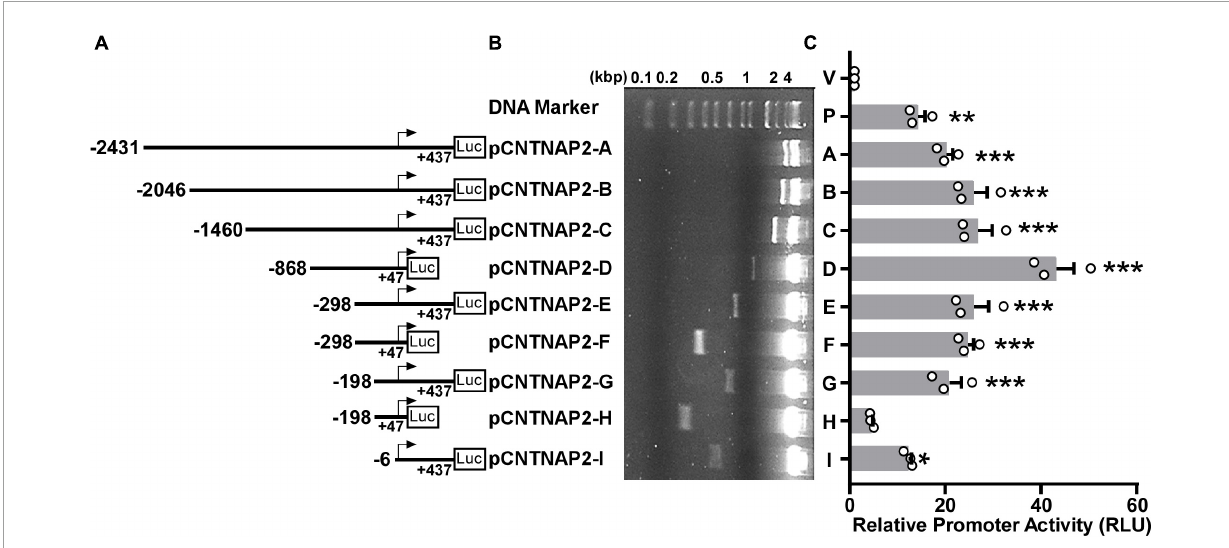
FIGURE4 Deletion analysis of the human CNTNAP2 gene promoter. (A) Schematic diagram of the human CNTNAP2 promoter deletion constructs. Various lengths of the human CNTNAP2 gene 5 (cid:48) flanking region were cloned into the pGL3-Basic promoter upstream of the Firefly luciferase gene (Luc). The numbers represent each fragment’s start and end positions relative to the transcription start site (TSS). (B) The plasmids used in the luciferase reporter assay were confirmed by restriction enzyme digestion, and the digested products were analyzed on a 1.5% agarose gel. (C) Functional analysis of human CNTNAP 2 gene promoter. pCNTNAP2 plasmids were co-transfected with pCMV-Luc into PC12 cells. 24 h post-transfection, cells were harvested for the dual-luciferase reporter assay. The relative luciferase activities were calculated by normalizing Firefly luciferase activities to the Renilla luciferase activities and represented by relative luciferase units (RLU). The activity of the pGL3-Basic vector (marked as V) was designated as 1 RLU, and the pGL3-Promoter (marked as P) served as the positive control. The values represent means ± SEM ( n = 3), * p < 0.05, ** p < 0.01, *** p < 0.001 by Dunnett’s multiple comparisons test, compared with the pGL3-Basic